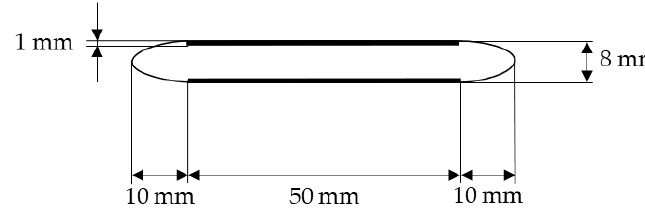
Figure 7. Dimensions of the fish-mouth actuator spring based on [72].